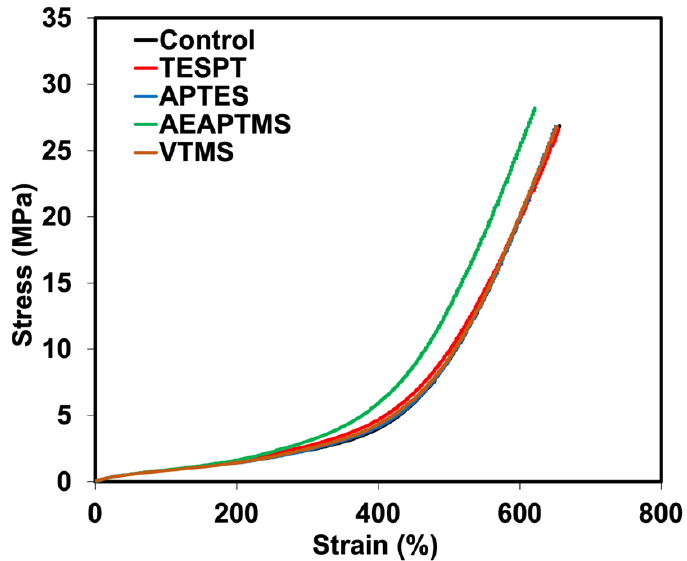
Figure 7. Stress-strain curves of NR/HNT composites filled with and without silane coupling agents. Table 3. Raw data extracted from the rheometric curves of NR/HNT composites filled with and without silane coupling